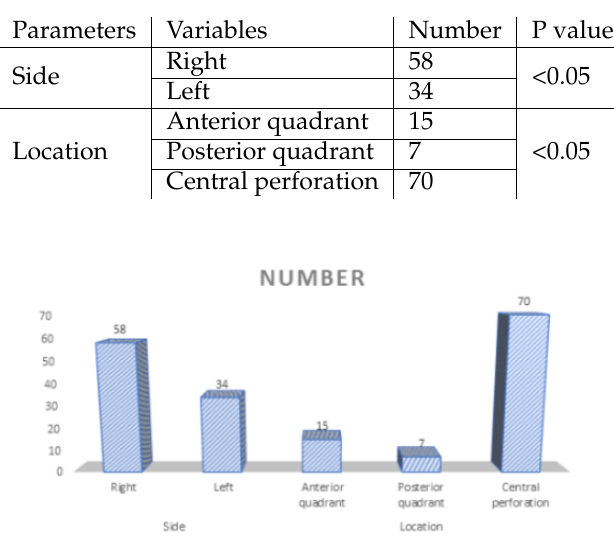
Figure 1. Graphical distrusting of clinical